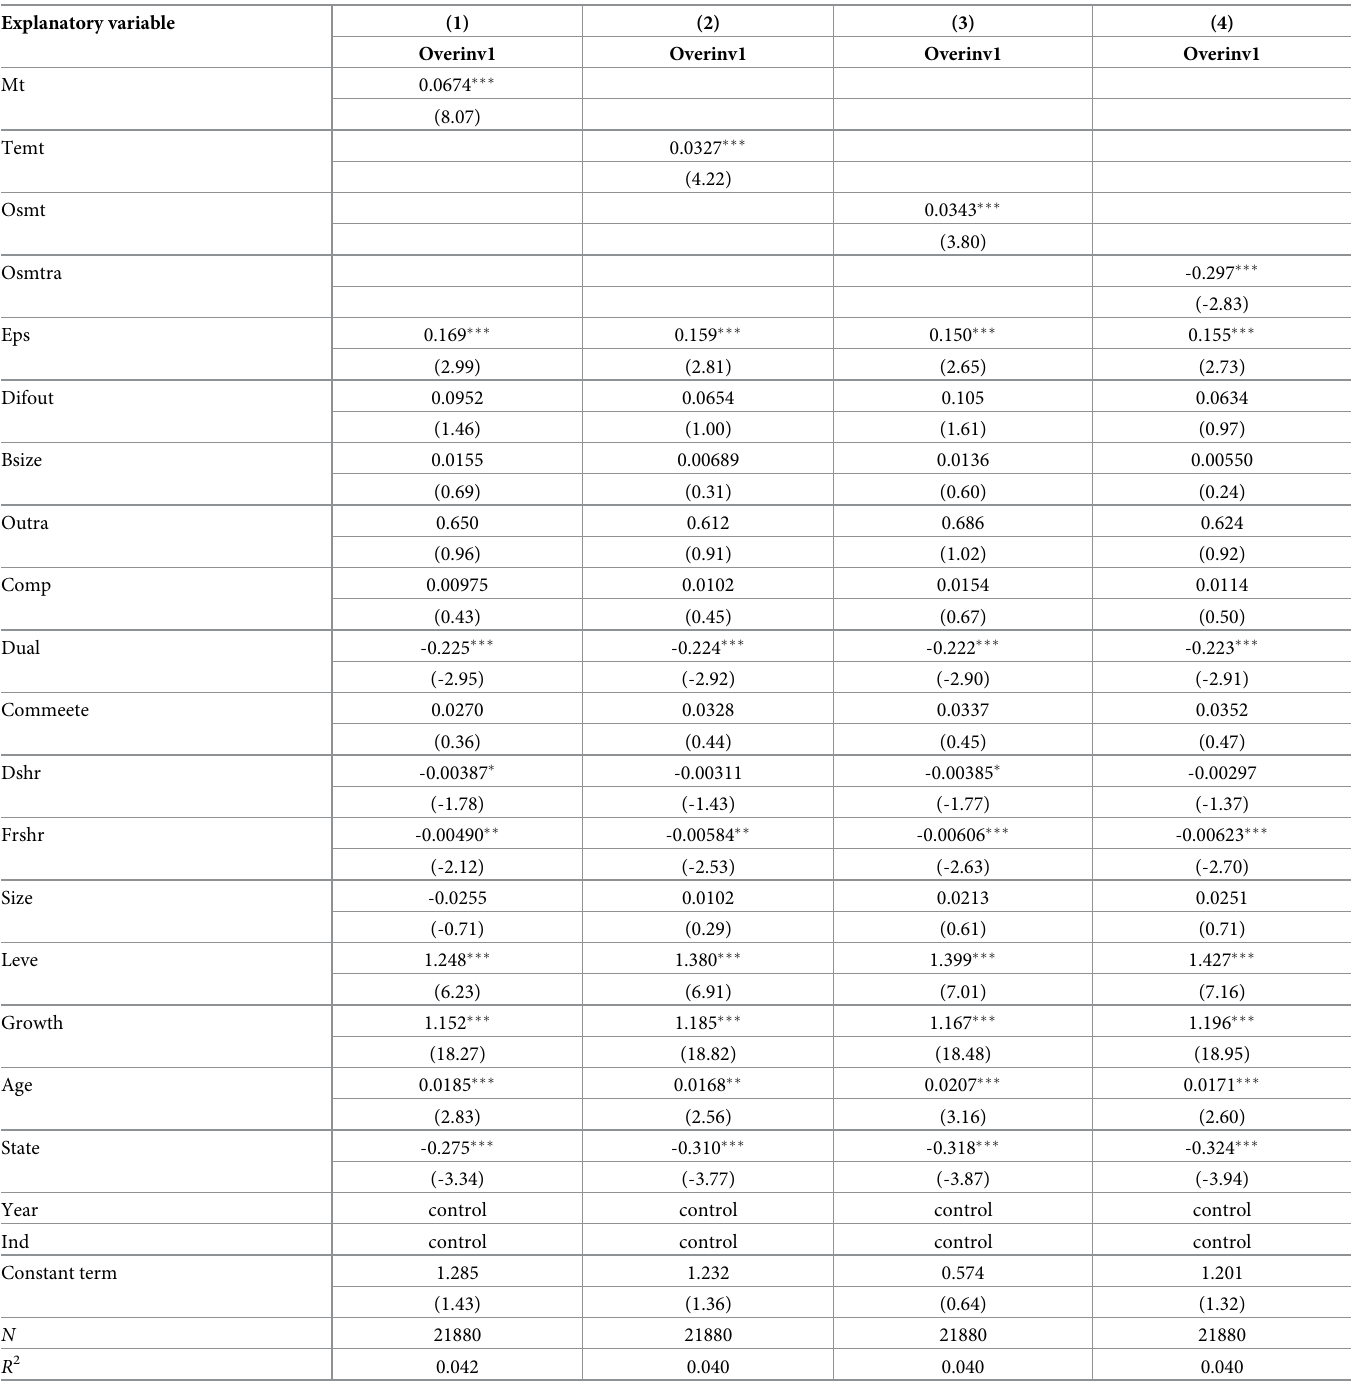
Table 9. The regression results of robustness